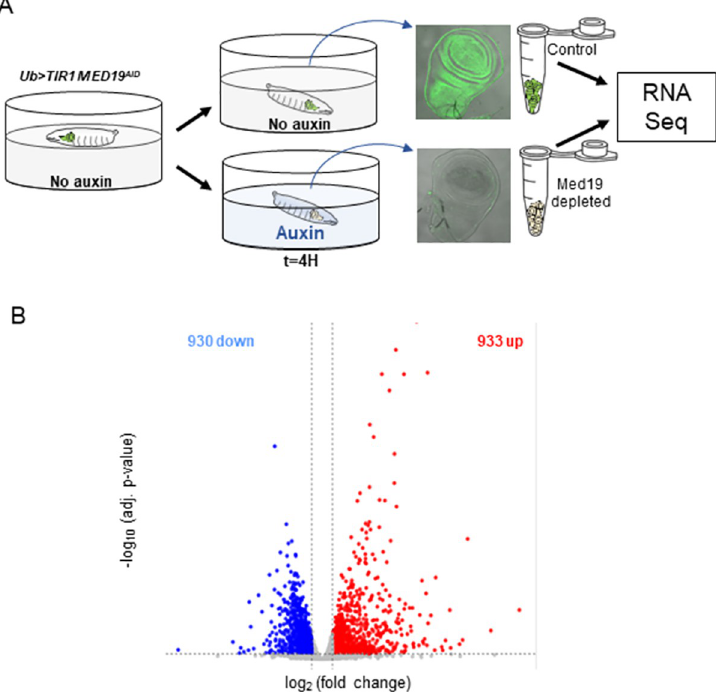
Fig 2. Med19 AID removal results in the deregulation a limited part of the wing imaginal disc transcriptome. (A) Scheme depicting the experimental setup used to produce wing imaginal discs from ub > TIR1 Med19 AID larvae in which Med19 AID degradation has been triggered, or not (no Auxin control- see GFP signal), upstream of the RNA-seq analysis. (B) Differential gene expression analysis volcano plot showing the expression fold change after Med19 AID degradation and associated adjusted p-values. 8753 genes found expressed in the wing imaginal disc are depicted. Genes with significative fold change (adjusted p-value < 0,05) are shown in blue for the down-regulated (log 2 FC < -0,5) and in red for the up-regulated (log 2 FC >